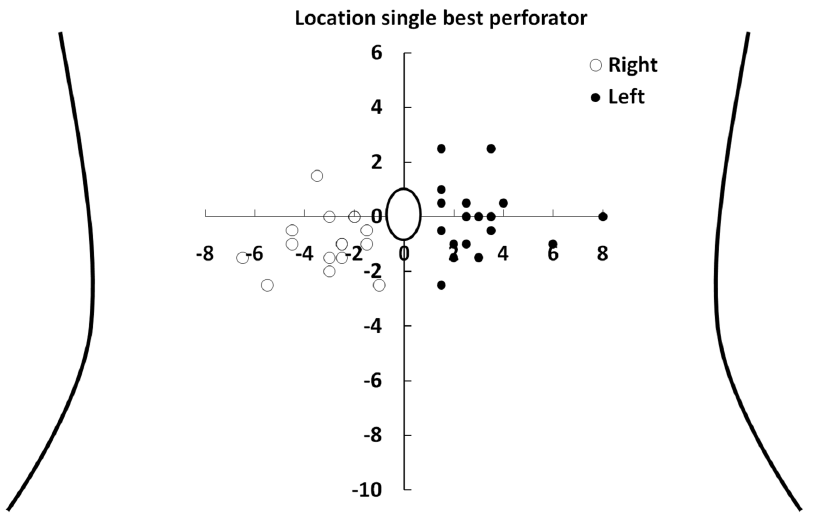
Figure 1. Schematic overview of 36 perforator branches of the deep inferior epigastric artery. Schematic overview of the abdomen and the location of 36 single best perforator branches of the deep inferior epigastric artery found during surgery and with equilibrium-phase high spatial resolution CE-MRA. The x- and y-axis represent the distance (in cm) in respect to the umbilicus.